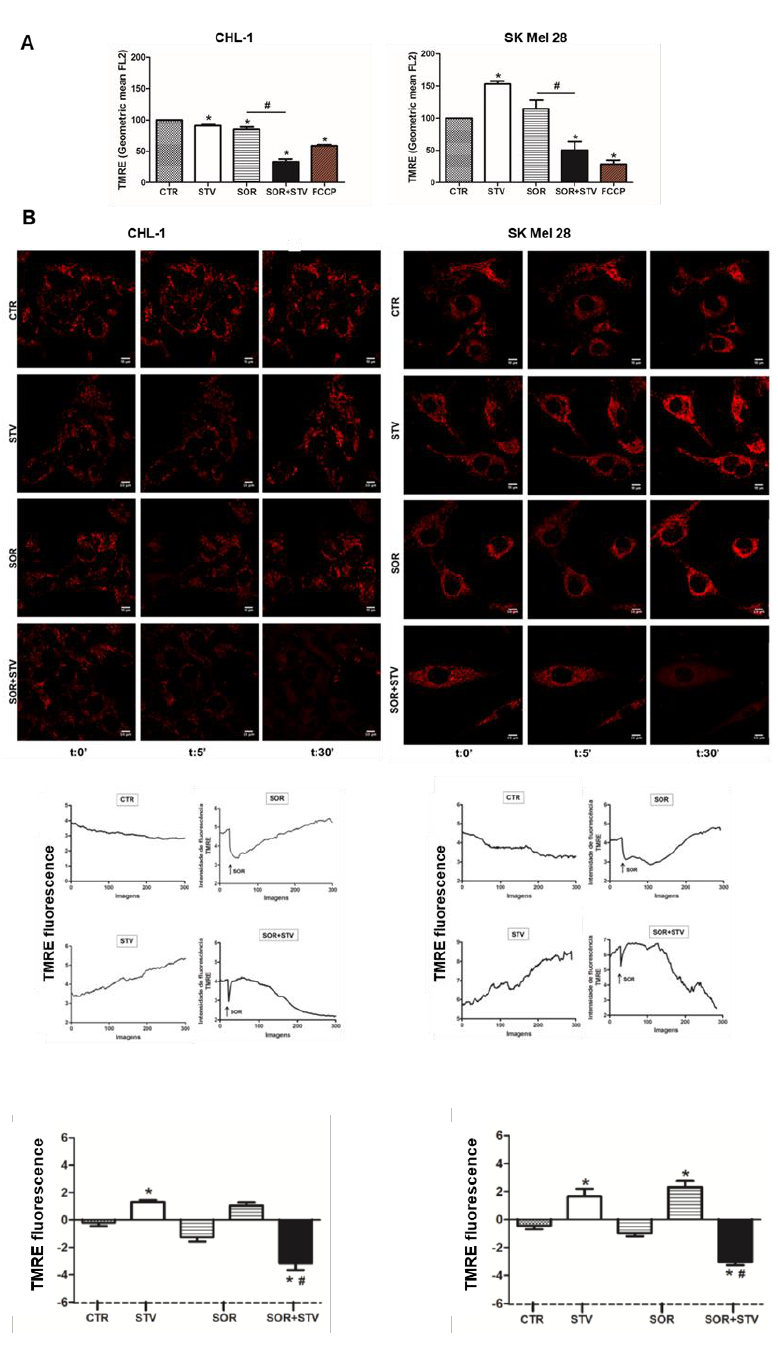
Figure 3. Combined exposure to sorafenib and starvation compromises mitochondrial function. ( A ) Mitochondrial membrane potential (MMP, ΔΨ) was evaluated by flow cytometric analysis of TMRE-stained CHL-1 or SK Mel 28 cells after STV, SOR, or SOR + STV exposure (2 h). FCCP was used as positive control. ( B ) Representative florescence images of three time points (t = 0′, t = 5′, and t = 30′) and time lapse analysis were performed by real-time confocal microscopy to evaluate ΔΨ in CHL-1 or SK Mel 28 TMRE-stained cells treated as indicated. Histograms represent the quantitative analysis of TMRE fluorescence variation after 30′ in both cell lines treated as indicated. (Images are representative of three independent experiments; histograms represent mean ± SD; n = 3) * p < 0.005 compared to control cells. # p < 0.0001 compared to sorafenib.